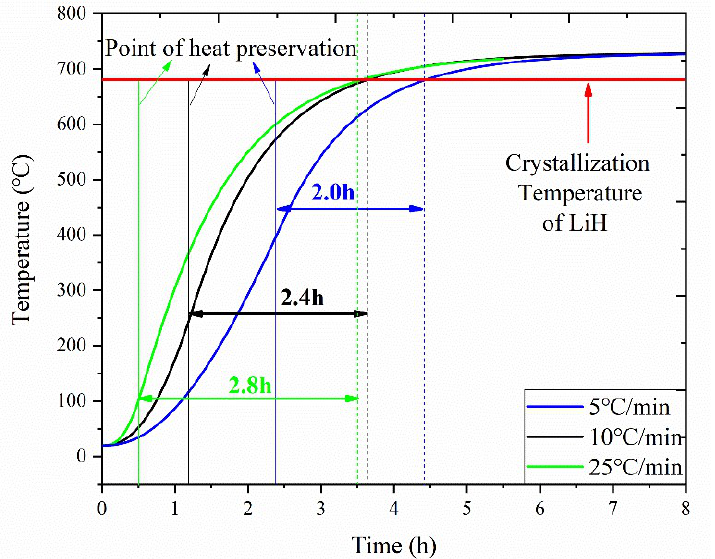
Figure 8. The temperature of LiH at the conical point during heating and heat preservation at a different heating rate.